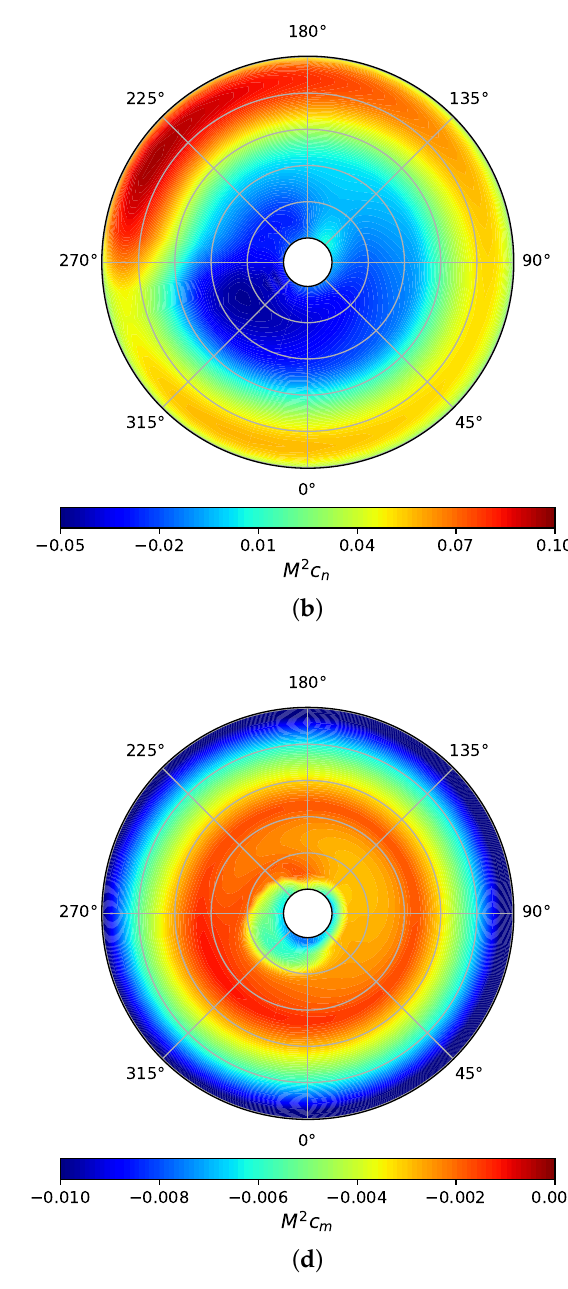
Figure 25. Comparison of the contours of the non-dimensional normal force M 2 c n and pitching moment M 2 c m on the proprotor blade in cruise, θ N = 0 ◦ , V ∞ = 160 kts, Ω = 517 RPM. ( a ) M 2 c n -CFD [17]; ( b ) M 2 c n -DUST; ( c ) M 2 c m -CFD [17]; ( d ) M 2 c m